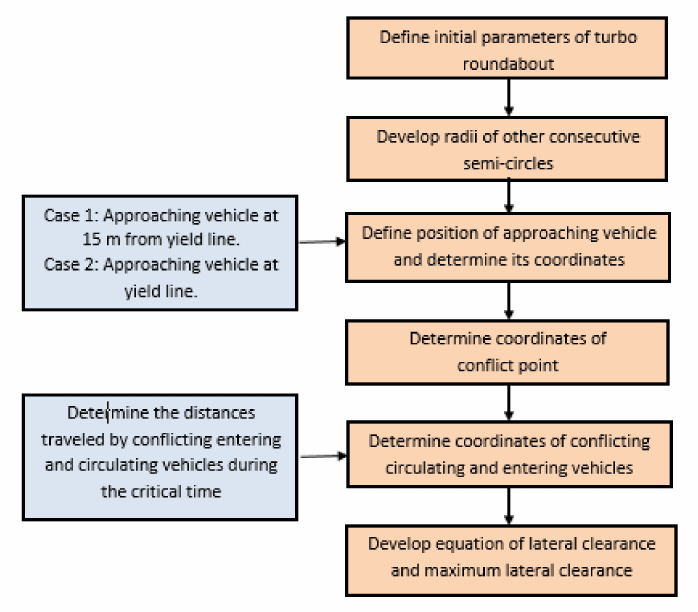
Figure 3. Procedure of ISD analysis of turbo